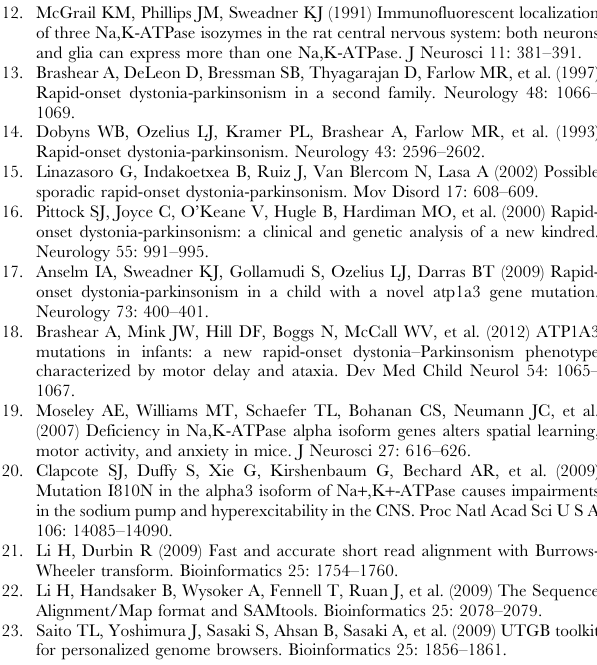
Table S1 PCR primers and conditions designed